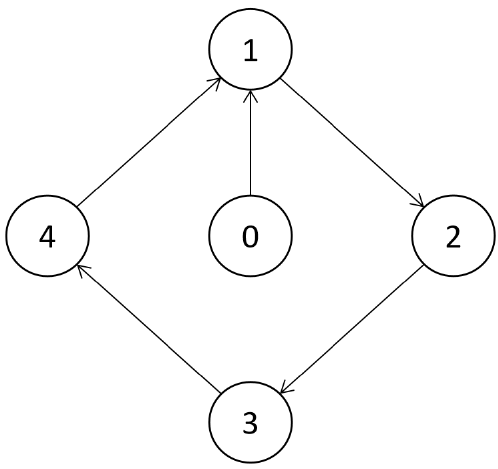
Figure 2. Directed interaction